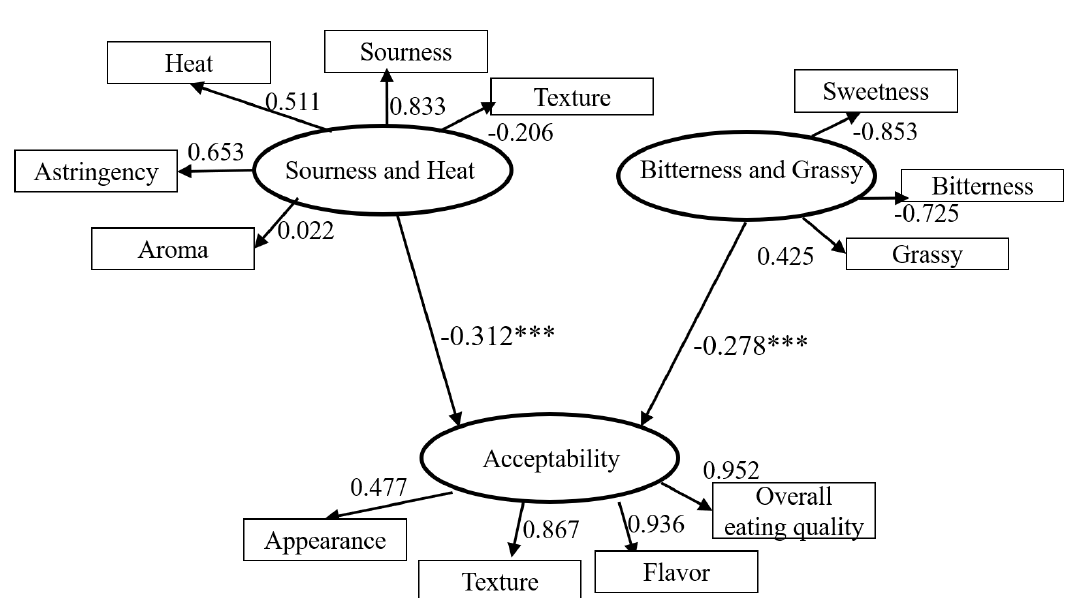
Figure 2. Partial least squares structural equation model (PLS-SEM) model and results. Each oval corresponds to a latent construct; each rectangle corresponds to a measured item or sensory attribute.